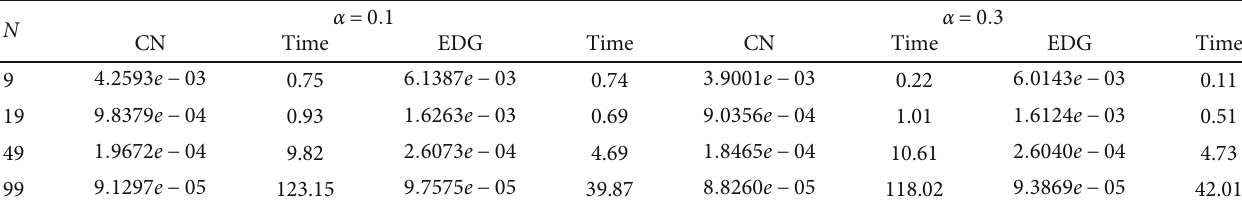
Table 1: Absolute errors of Example 13 at T = 1 for Re = 10 , Δ t = 0 : 01 , α = 0 : 1 , and α = 0 : 3 .